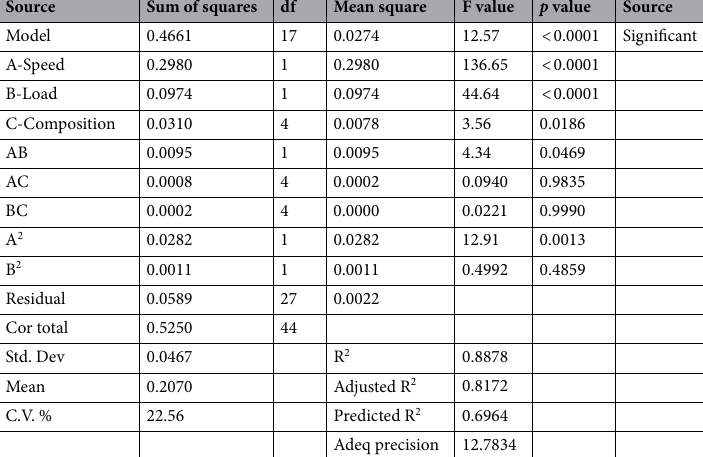
Table 7. ANOVA and summary of fit statistics for response 3 (wear